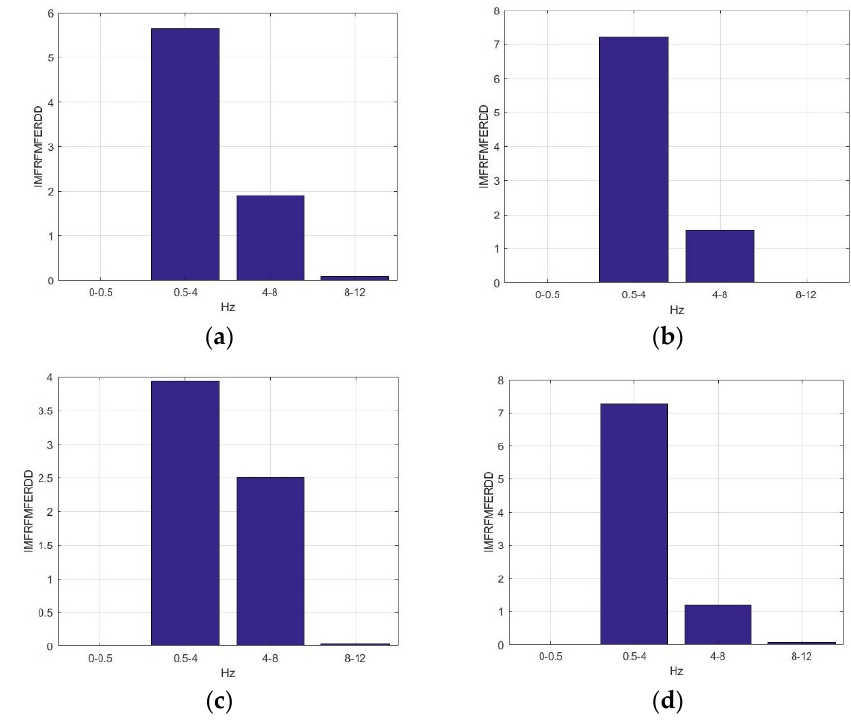
Figure 6. Average IMFRFMFERDD values of IMF3 (MF3) in ILF, delta, theta, and alpha rhythms for F5AM, F5MI, F6AM, and F6MI, respectively. ( a ) Average IMFRFMFERDD values (F5AM MF4), ( b ) average IMFRFMFERDD values (F5MI MF4), ( c ) average IMFRFMFERDD values (F6AM MF4), ( d ) average IMFRFMFERDD values (F6MI MF4).